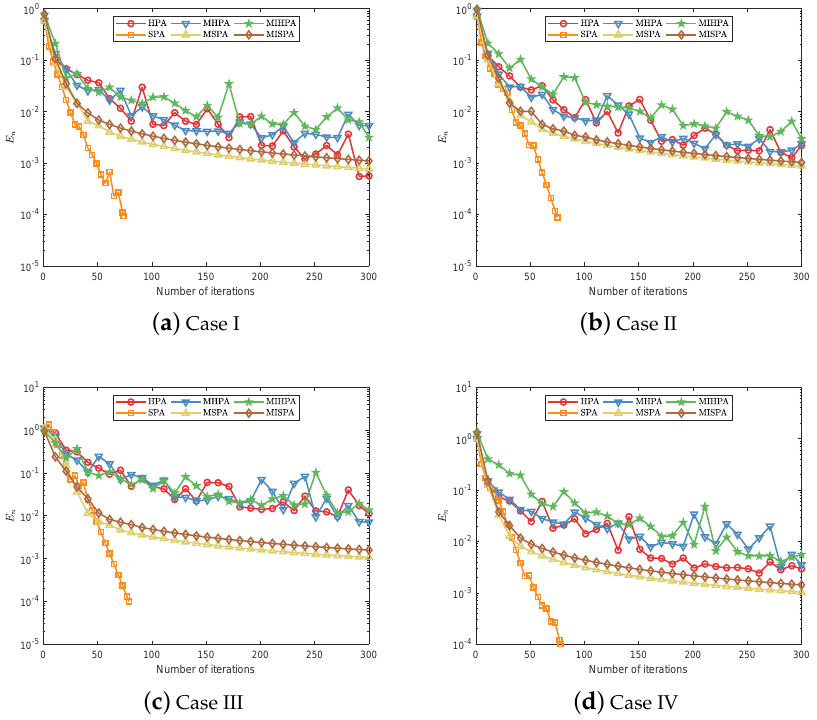
Figure 2. Convergence behavior of iteration error { E n } for Example